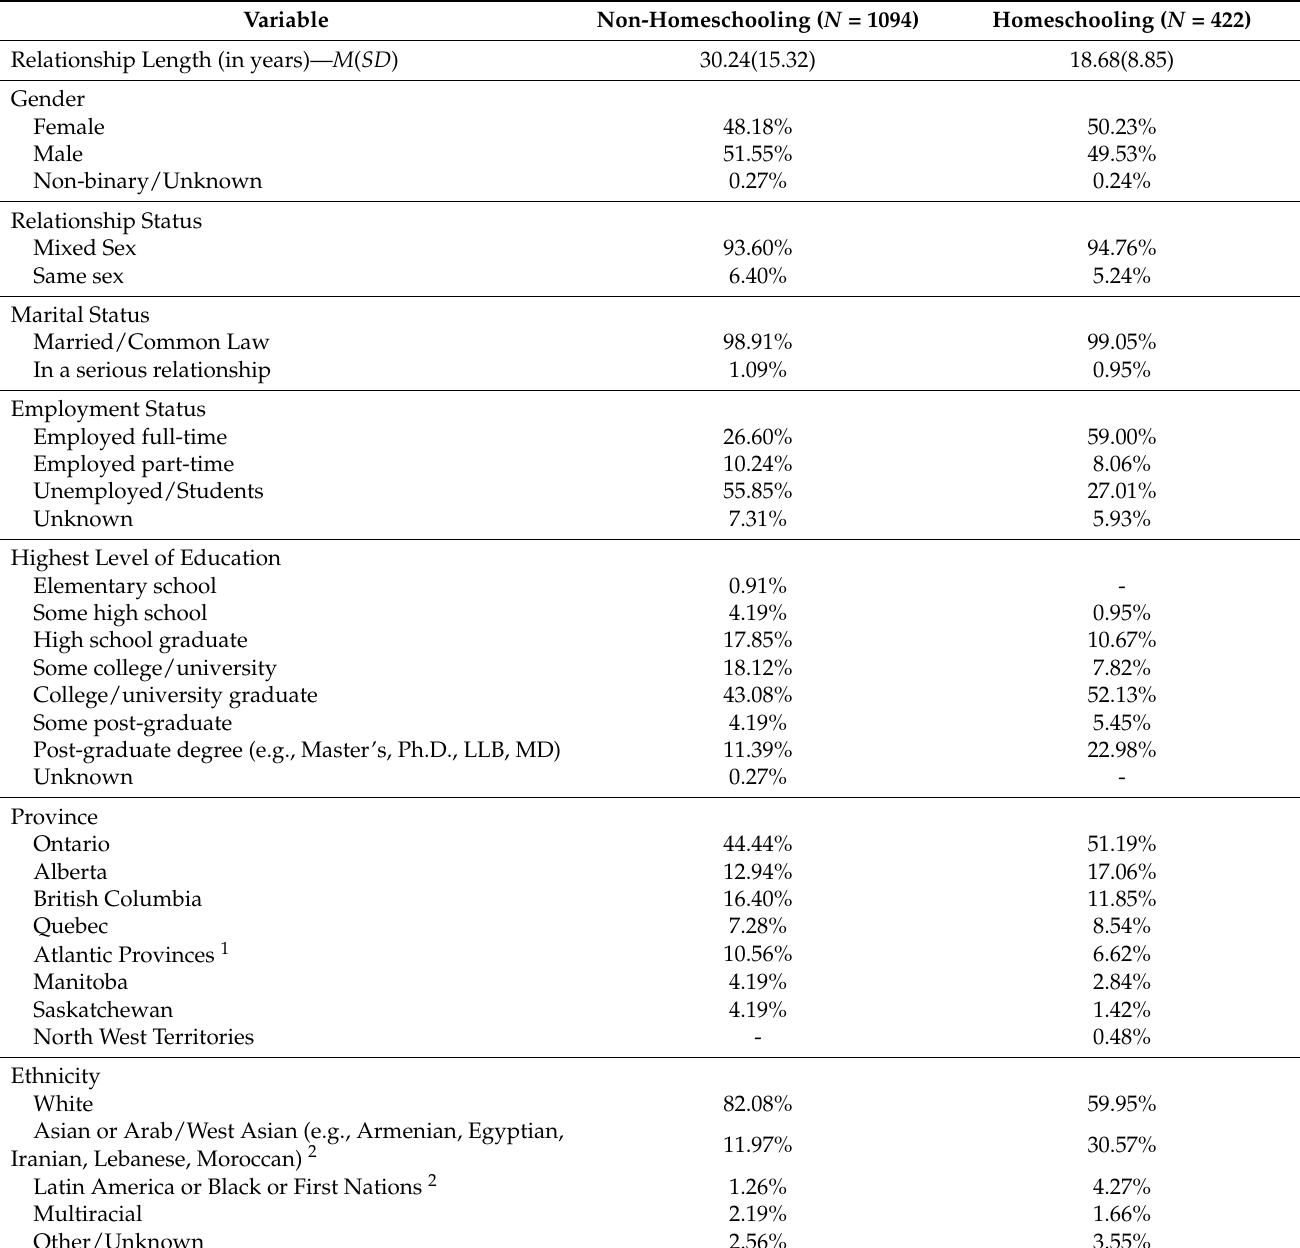
Table 1. Demographics information and relationship characteristics for homeschooling and non-homeschooling romantic couples living in